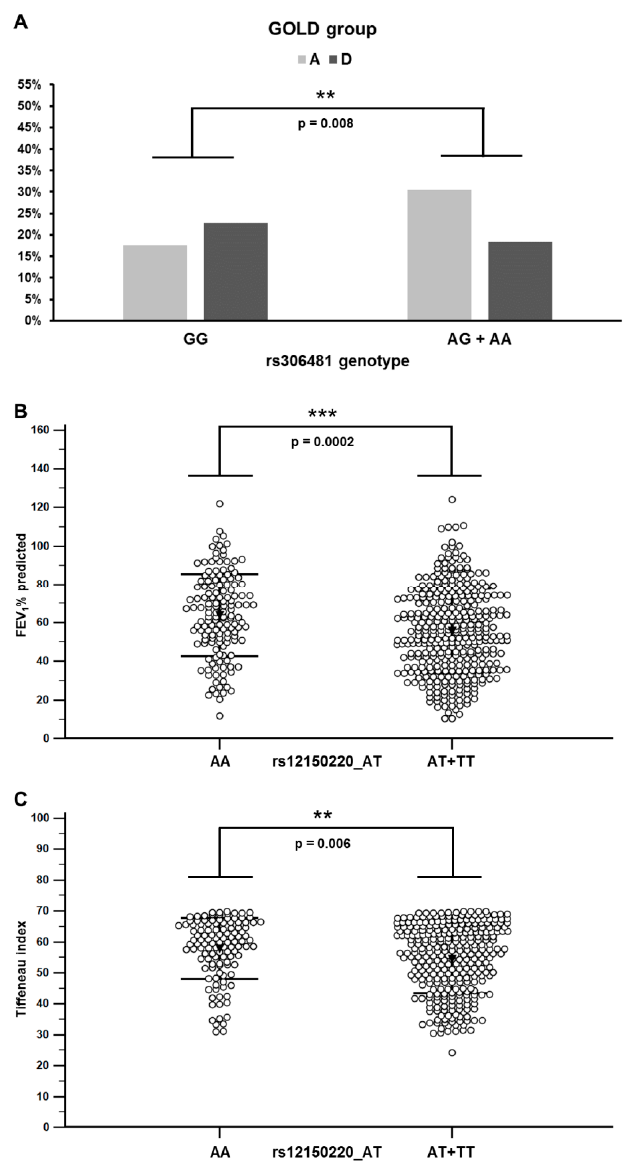
Figure 2. Distribution of the GOLD groups among rs306481 genotypes and the association of the rs12150220 genotypes with spirometric parameters in COPD patients. ( A ) Allele A carrier status in the tested locus correlated with the milder GOLD stages; refer to Table 3 for the results of the statistical analysis. Numbers present the percentage of individuals with indicated GOLD status. ( B ) Patients with genotypes involving minor allele T showed lower FEV 1 predicted values. ( C ) Patients with genotypes involving minor allele T showed lower FEV 1 /FVC ratio (Tiffeneau index). Bars represent standard deviation and the black triangle represents the mean value. Stars indicate statistically significant differences ( p < 0.05).